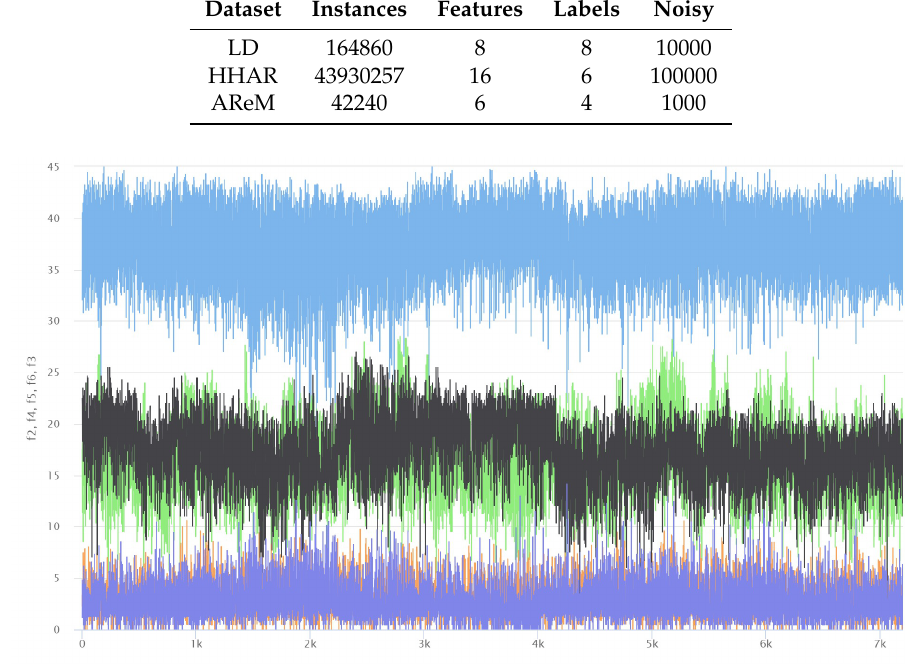
Figure 4. Visualization of AreM dataset which is a graph of time-series of five feature values: it shows that all the time-series are stationary without any significant and distinctive shape, fluctuating within a limited range of